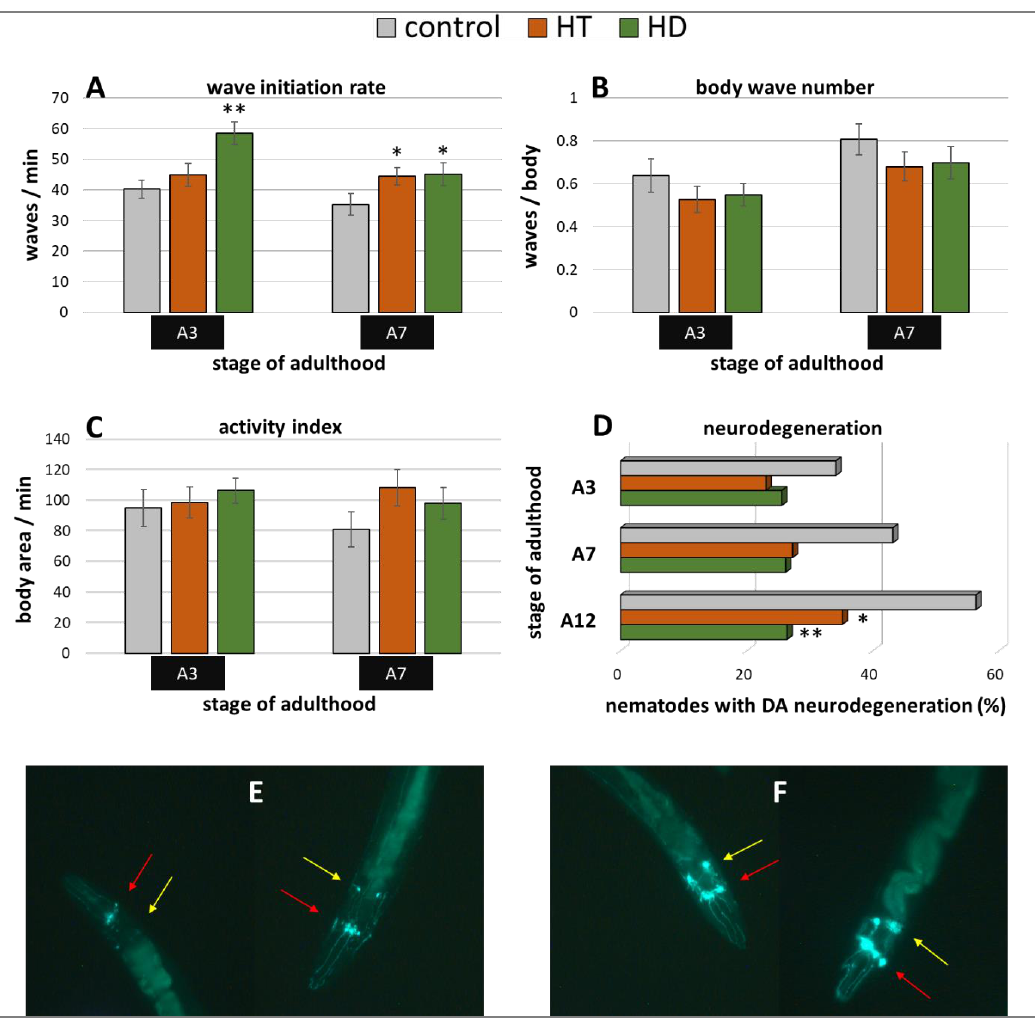
Figure 6. Benefits from HD & HT treatment in the UA44 strain. The nematode strain UA44 is characterized by α-synuclein as well as GFP expression in dopaminergic neurons. After polyphenol treatment, the wave initiation rate ( A ), the body wave number ( B ) and the activity index ( C ) were determined in two independent trials with ≥48 nematodes per treatment and age. Furthermore, the neuronal viability was analysed in three trials with ≥39 nematodes per treatment and age by fluorescence microscopy using a green filter. Shown are the percentages of nematodes with degenerated dopaminergic anterior neurons with and without polyphenolic treatment ( D ). Data are presented as mean ± SEM. Differences compared to control were considered significant at p < 0.05 (*) and p < 0.001 (**). A3, A7, A12: 3rd, 7th and 12th day of adulthood. Two nematodes with neurodegeneration characterized by missing or weak fluorescence in the DA neurons ( E ) as well as two nematodes with intact neuronal appearance ( F ) are shown. The DA neurons are sub-classified as four CEP neurons (red arrows), which are superimposed in most pictures and two ADE neurons (yellow arrows).